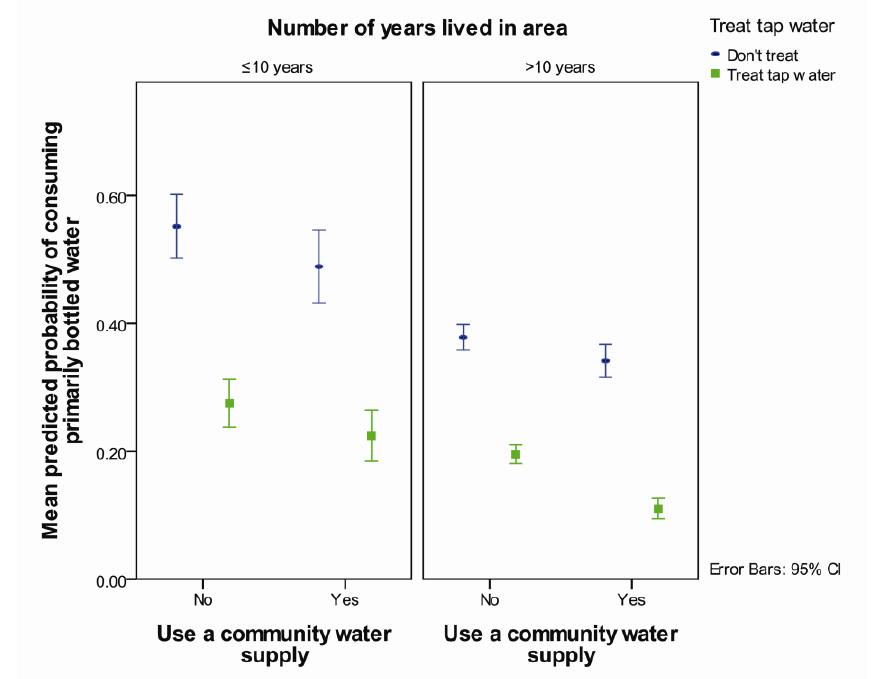
Figure 3. Predicted probability of consuming primarily bottled water by use of a community water supply and in-home treatment of tap water separated by length of residence in the area averaged over reported aesthetic complaints, agreement that tap water is not safe to drink and whether the household experienced a water